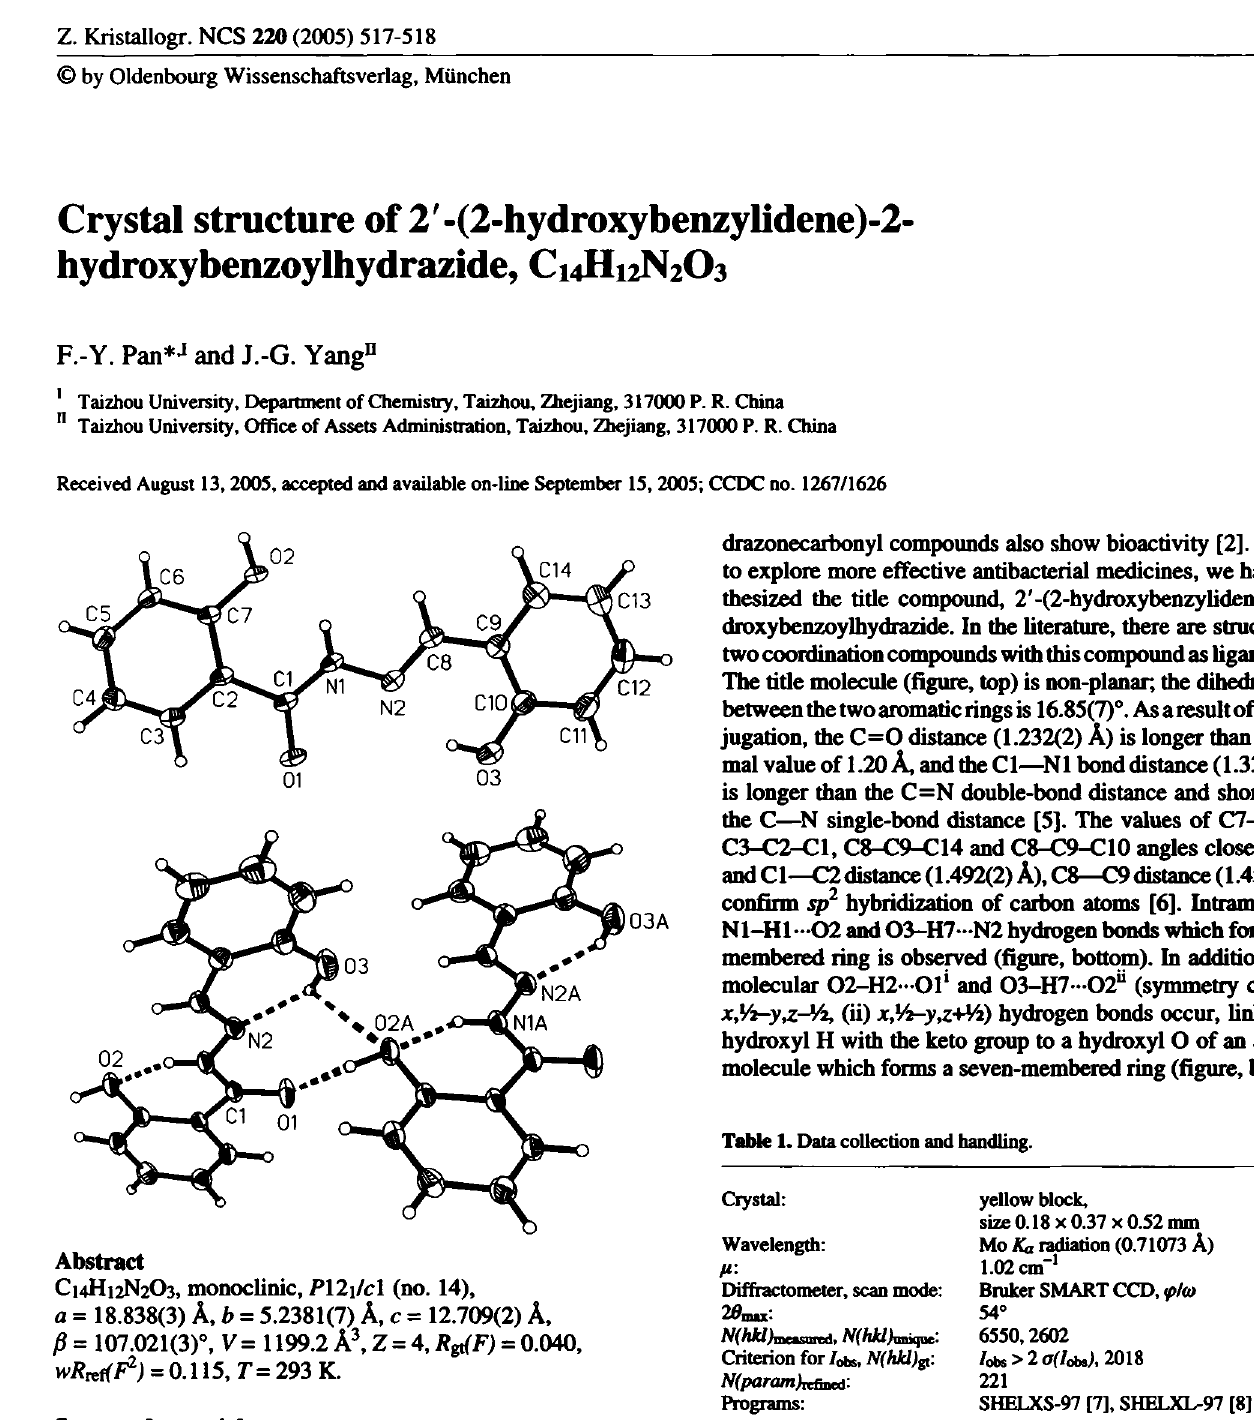
Table 2. Atomic coordinates and displacement parameters (in A 2